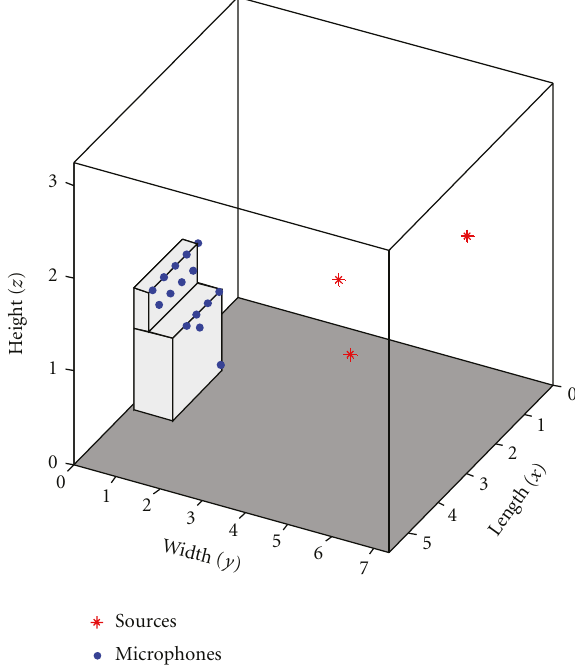
Figure 7: Schematic representation of real-data recording